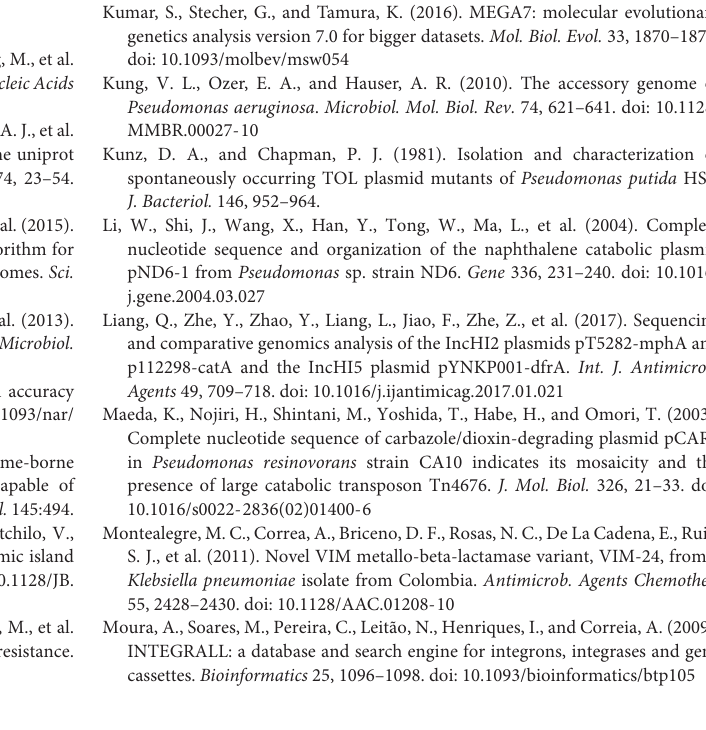
FIGURE S1 | Plasmid schematic maps. Three plasmids pCAR1, pDK1 and p1160-VIM are included. Genes are denoted by arrows, and the backbone and accessory module regions are highlighted in black and color, respectively. Innermost circle presents GC-skew [(G − C)/(G + C)], with a window size of 500 bp and a step size of 20 bp. Next-to-innermost circle presents GC content. FIGURE S2 | ICE schematic maps. Four ICEs Tn 6413 , Tn 6534 , Tn 6533, and Tn 6417 are included. Genes are denoted by arrows, and the backbone and accessory module regions are highlighted in black and color, respectively. Innermost circle presents GC-skew [(G − C)/(G + C)], with a window size of 500 bp and a step size of 20 bp. Next-to-innermost circle presents GC content. FIGURE S3 | Alignment of repA nucleotide sequences. Red-labeled nucleotides indicate SNP sites. Sequence of IncP-7 β reference plasmid pDK1 was bolded. FIGURE S4 | Organization of Tn 4676 or Tn 4663 comparison with related regions. Genes are denoted by arrows. Genes, mobile elements and other features are colored based on their functional classification. Blue shading denotes regions of homology (nucleotide identity > 95%), and pink shading denotes regions of homology (average nucleotide identity 82%). Numbers in brackets indicate nucleotide positions within corresponding plasmid sequences. Accession number of Tn 4651 for reference is AJ344068. TABLE S1 | Collection of repA and iteron sequences of IncP-7 plasmids. TABLE S2 | Pairwise comparison of repA and backbone sequences. TABLE S3 | List of the Tn6417 -related